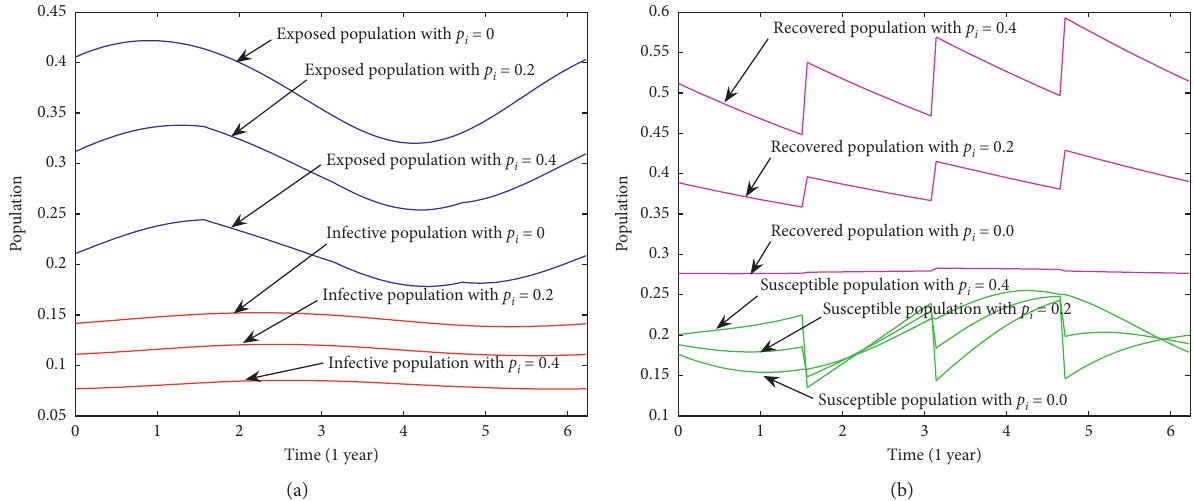
Figure 3: Exposed population, infective population, recovered population, and susceptible population with p